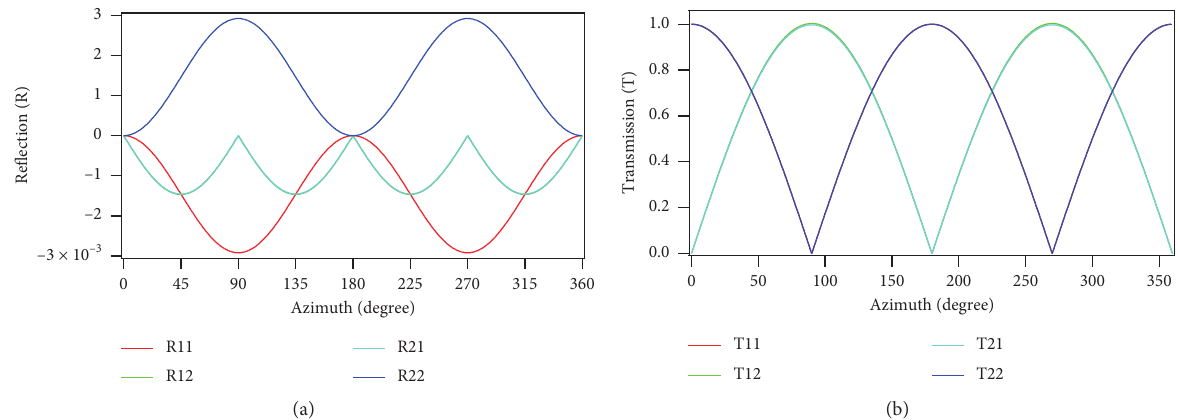
Figure 4: The reflection and transmission coefficients in the anisotropy-anisotropy interface. The upper layer remains fixed, and the lower layer rotates from 0 to 2 π in the horizontal